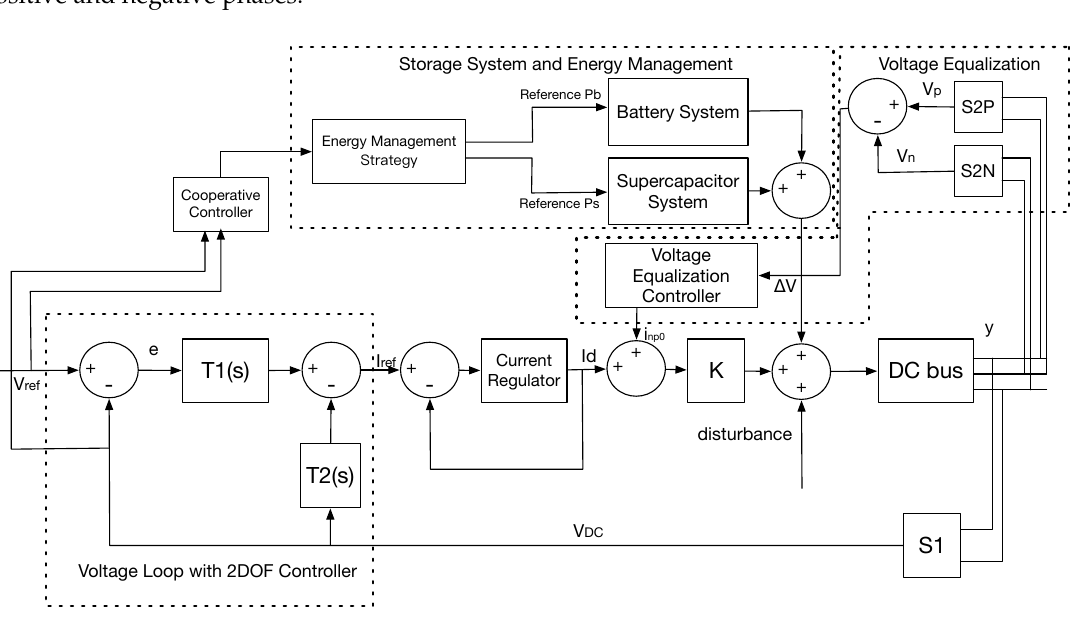
Figure 3. Proposed control and energy management